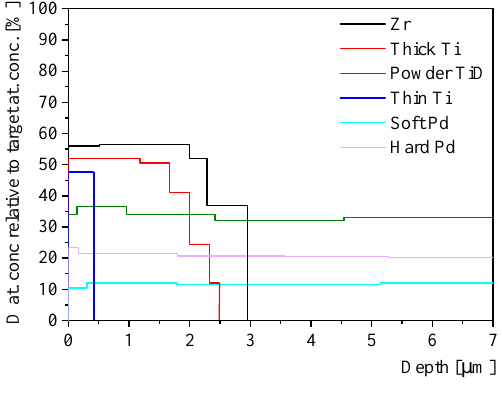
Figure 1. Deuterium concentration relative to the number of target atoms as a function of depth in the target, measured in Zr (black line), thick Ti (red line), powder Ti (green line), thin Ti (blue line), soft Pd (purple line) and hard Pd (light blue line) targets using the Nuclear Reaction Analysis technique. Deuterium concentration errors are estimated to be ∼